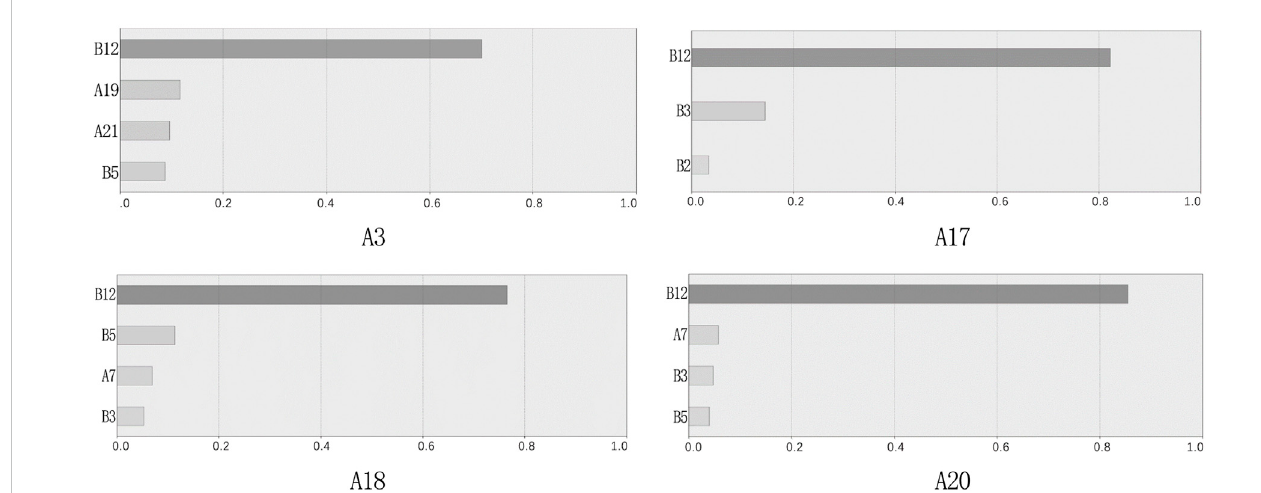
FIGURE 5 The independent effects of explanatory variables.